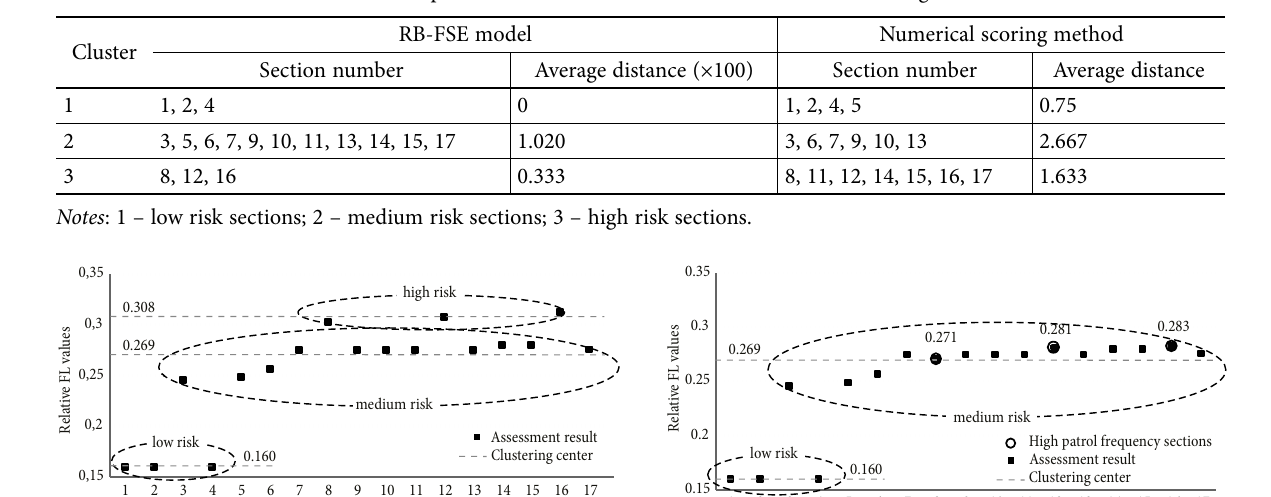
Table 3. The comparison between RB-FSE model and numerical scoring method